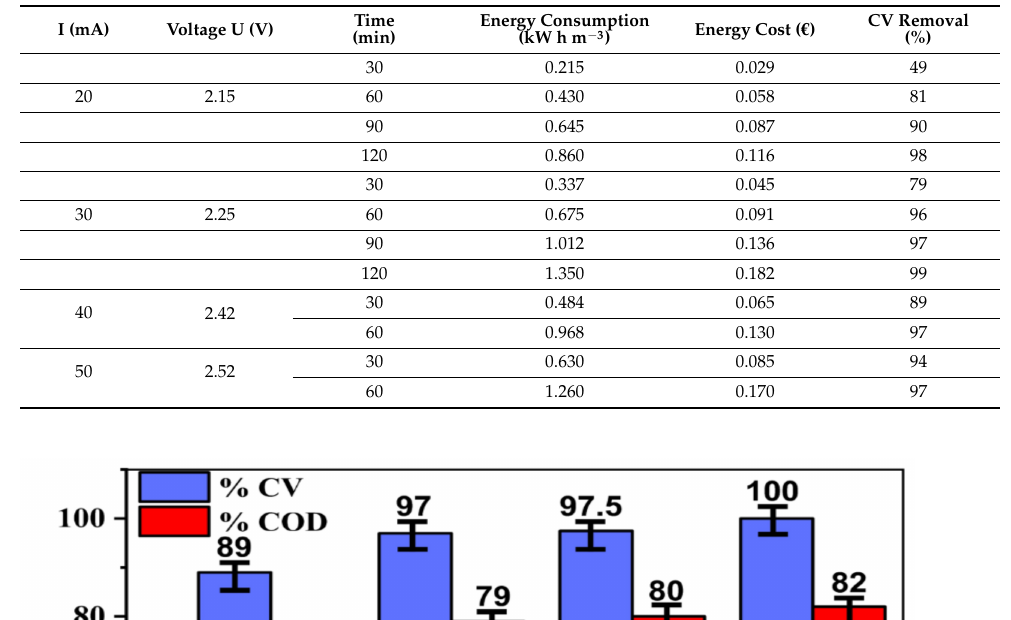
Table 2. Energy requirements and costs for electrochemical treatment of solution containing CV at different time of treatment.